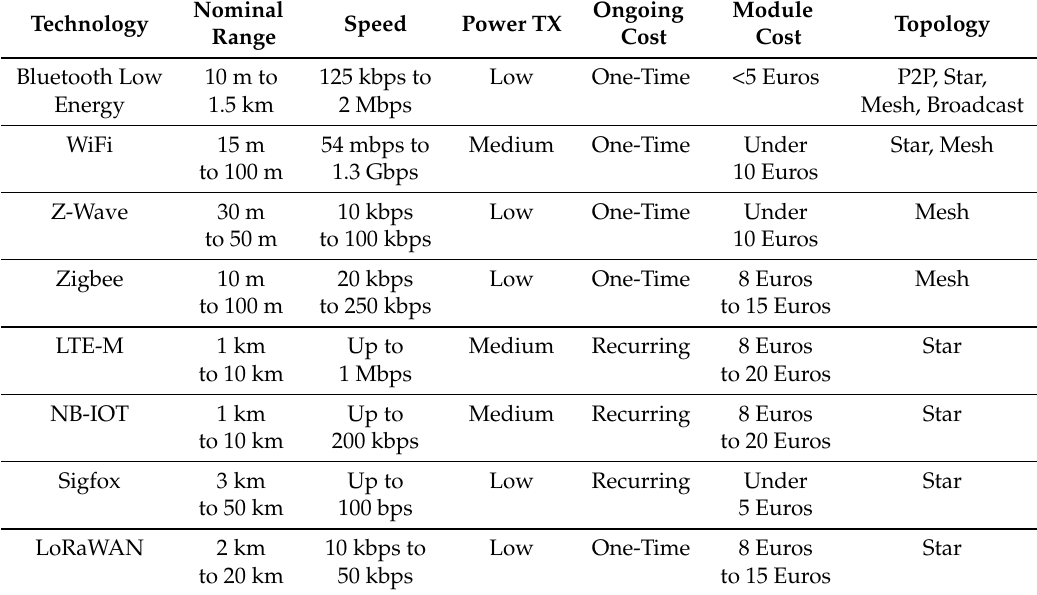
Table 2. Wireless data transmission technology